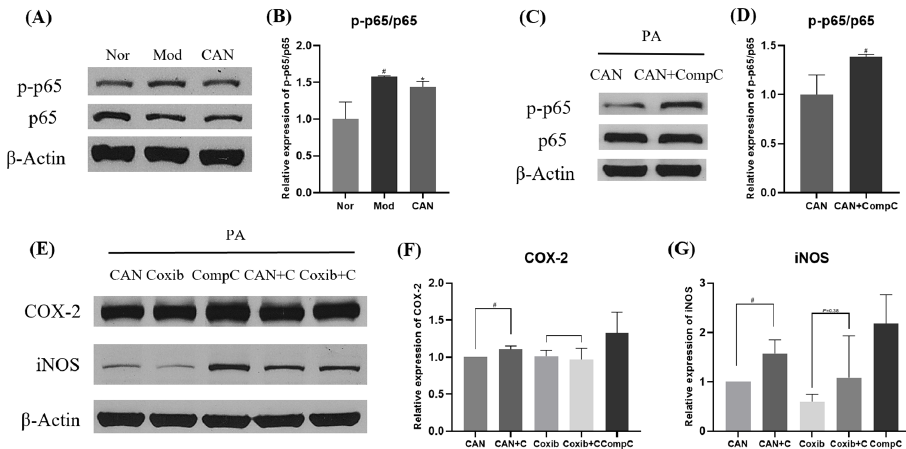
Figure 7. Canagliflozin inhibits p-p65/COX-2/iNOS inflammatory pathway by activating AMPK. HL-1 cells were stimulated with 0.1 mM PA for 24 h in the presence or absence of CAN (5 µ g/mL), and the whole cell lysates from HL-1 cells were used for Western blotting analysis. ( A , B ) Effects of CAN on the ratios of p-p65/p65 in HL-1 cells. ( C – G ) HL-1 cells were treated with 0.1 mM PA and CAN (5 μ g/mL)/Coxib (5 μ g/mL) for 24 h in the presence or absence of Compound C (5 μ g/mL), and the effects of AMPK inhibitor CompC on COX-2 and iNOS and the ratio of p-p65/p65 were analyzed. Nor, normal control group; Mod, untreated PA control group; CAN, CAN-treated PA group; Coxib, coxib-treated PA group; CompC, Compound C-treated PA group. Data were expressed as mean ± SD ( n = 3). Differences were considered significant at p < 0.05 and highly significant at p < 0.01 (# p < 0.05 vs. Nor; * p < 0.05 vs. Mod).